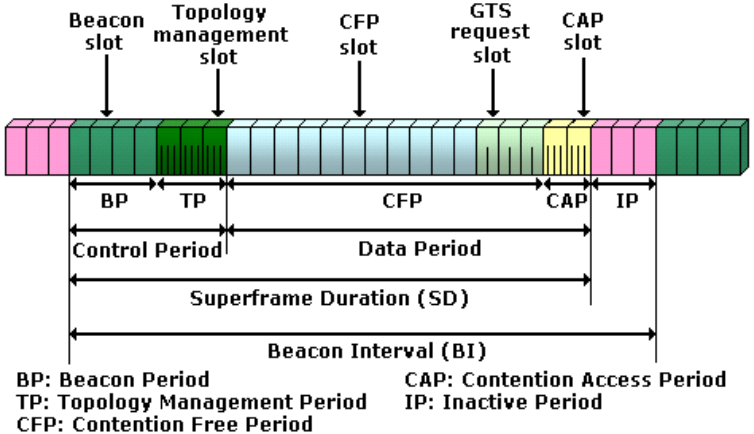
Figure 2. Proposed MAC superframe